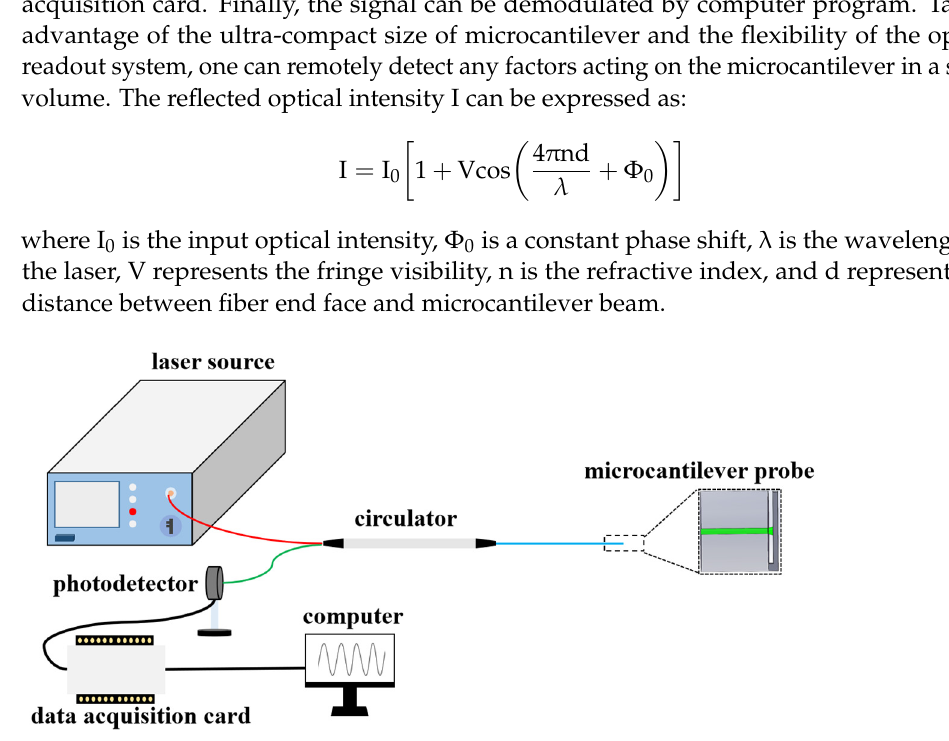
Figure 2. Experimental setup of the microcantilever probe readout system.